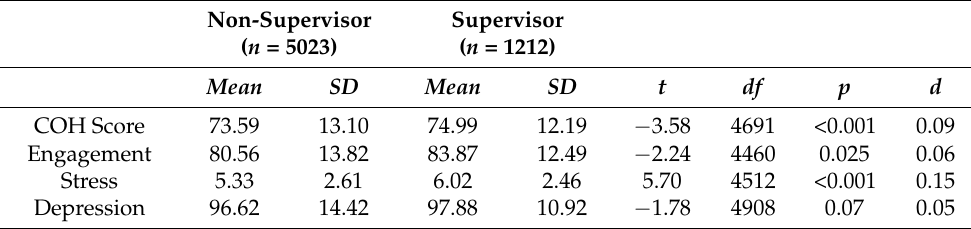
Table 2. Descriptive statistics and results of t -test comparison of employee outcome variable by job